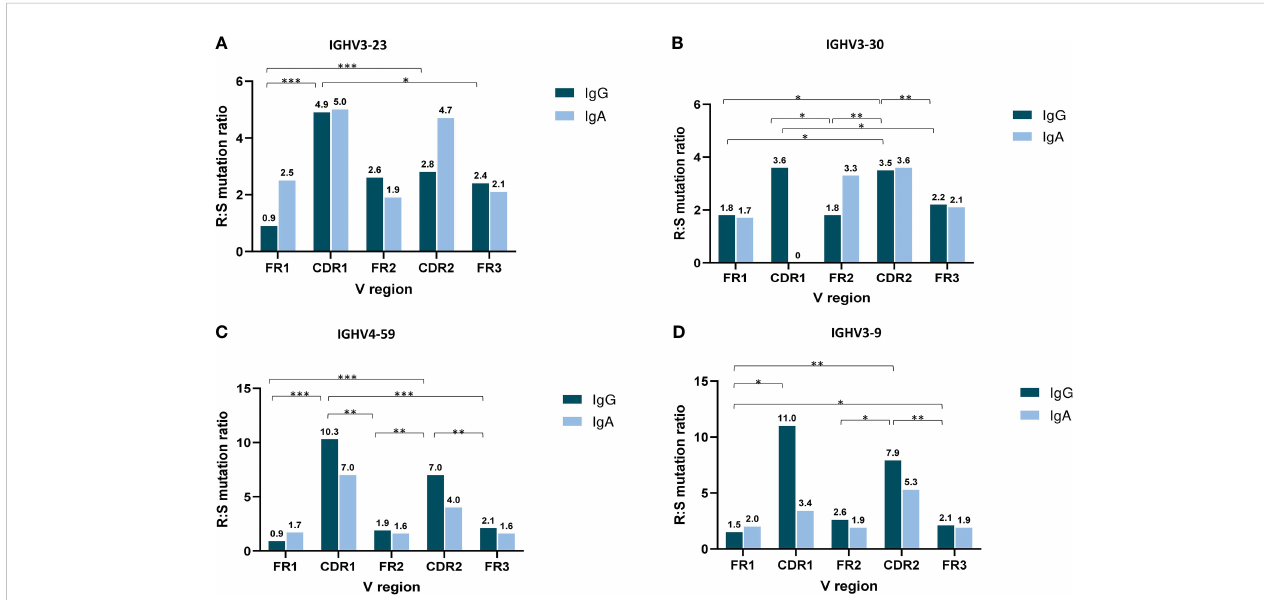
FIGURE 4 Topology of somatic hypermutation in IgA versus IgG multiple myeloma. Ratio of replacement to silent mutations (R:S) in the VH FRs and VH CDRs in cases expressing the 4 commonly frequent IGHV genes of MM patients with IgG and IgA isotypes: IGHV3-23 (A) , IGHV3-30 (B) , IGHV4-59 (C) and IGHV3-9 (D) . Asterisks indicate the statistically signi fi cant differences between the VH FR and VH CDR regions (p-value ≤ 0.05(*), p-value ≤ 0.01 (**) and p-value ≤ 0.001